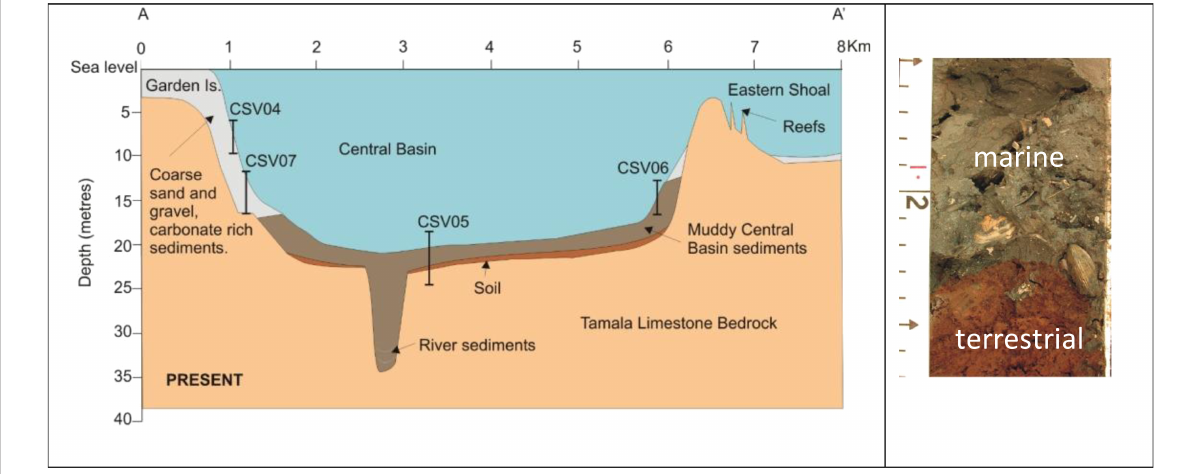
Figure 6 StratigraphiccrosssectionofCockburnSound,incorporatingdataobtainedfromvibrocores(sourcedfromandreproducedwithpermissionfromSkene 2005; their Figures 21 and 17E respectively). Scalebar on right is in cm increments.